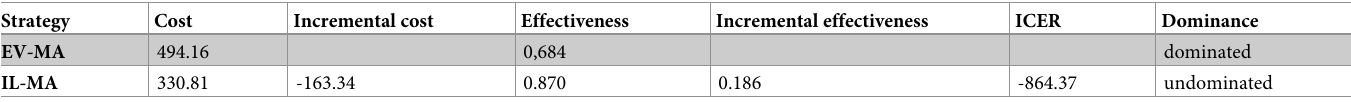
Table 3. Cost-effectiveness analysis of meglumine antimoniate intralesional infiltration compared to endovenous meglumine antimoniate for cutaneous leishmani- asis treatment in Brazil.